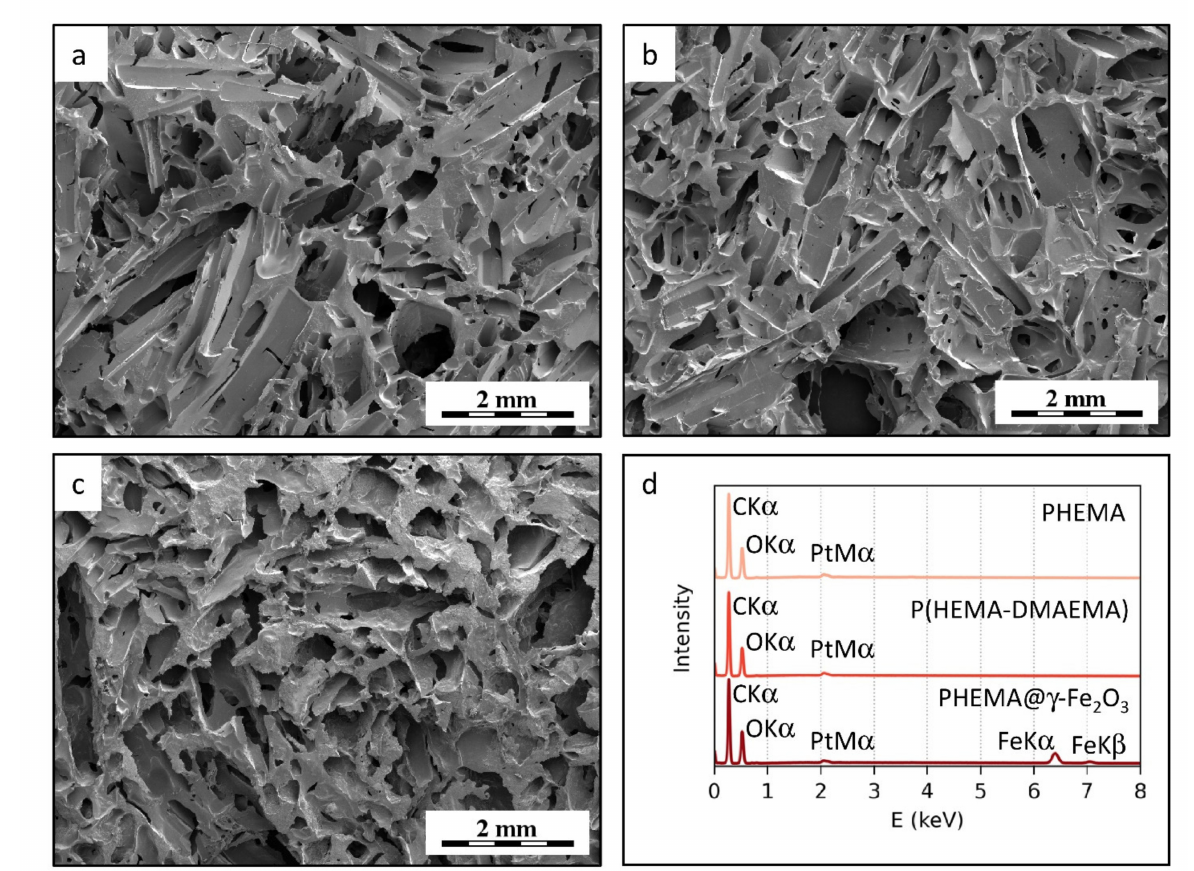
Figure 2. SEM micrographs of ( a ) PHEMA, ( b ) P(HEMA-DMAEMA), and ( c ) PHEMA@ γ -Fe 2 O 3 hydrogels, and ( d ) their EDX spectra that proved the presence of γ -Fe 2 O 3 in the PHEMA@ γ -Fe 2 O 3 hydrogel.